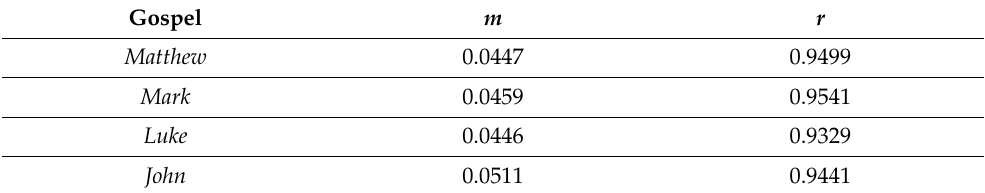
Table 13. Slope m and correlation coefficient r of the regression line between the number of sentences n S (dependent variable) and the number of words n W (independent variable) per chapter, in the canonical Gospels. Four decimal digits are reported because some values differ only from the third